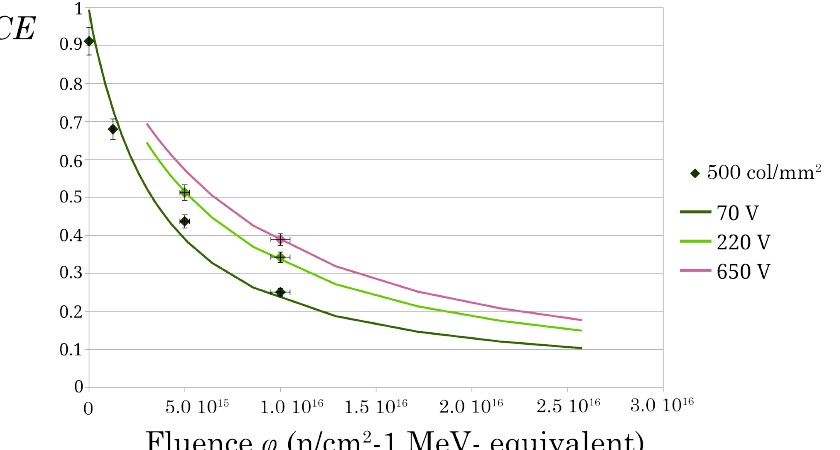
Figure 14. Measured and simulated CCE at increasing bias voltages, for the 500 col/mm 2 3D sensor. We plotted the experimental points until the highest voltage level allowed by our power supply. The CCE curves tend to zero as fluence increases (and lifetime decreases). Nonetheless, a high irradiation level permits to increase in the bias voltage, so the sensors are operative in the 10 16 n/cm 2